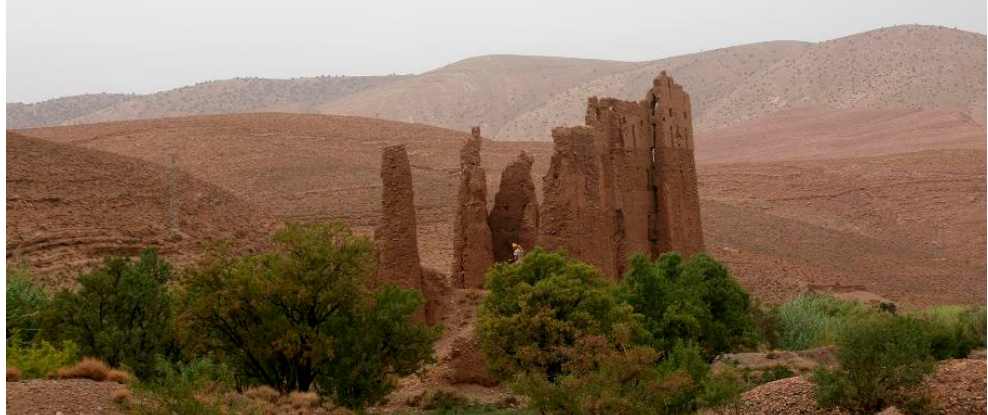
Figure 2. The Water Guardian Kasbah, Mgoum Valley. High Atlas.